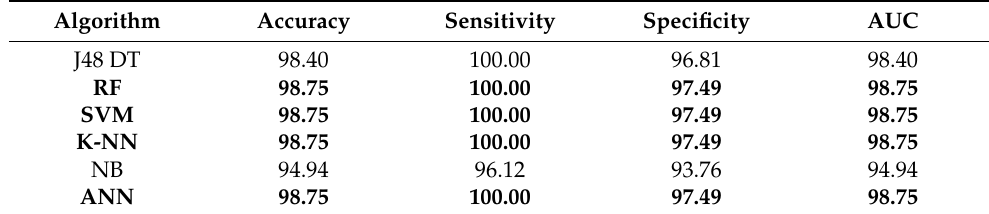
Table 16. Developed model’s performance evaluation result